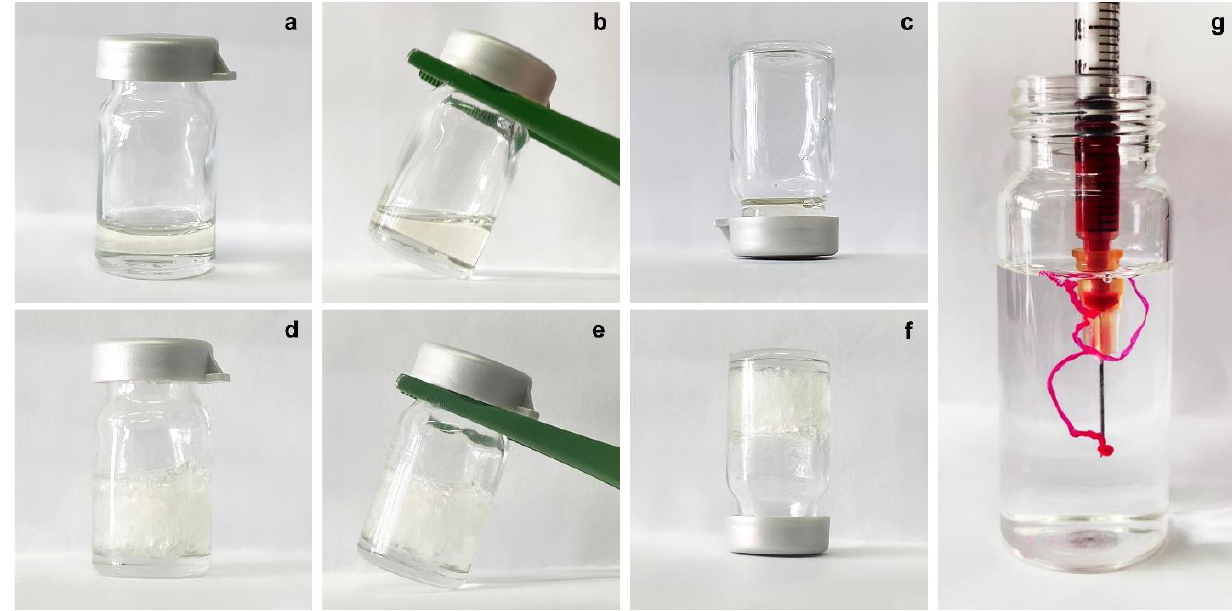
Figure 2. Representative photographs of the transition process from ( a – c ) precursor solution to ( d – f ) fully swollen cubic phase according to the test-tube inversion method; ( g ) instantaneous transition of precursor solution when injected in SVF with a 25G insulin syringe. The reported photographs refer to the drug-loaded formulations, as no macroscopic differences occurred with respect to the empty formulations.